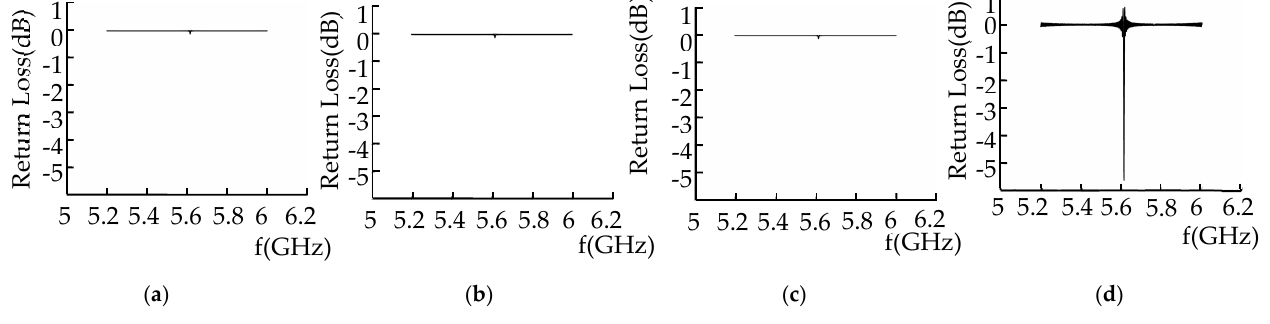
Figure 12. Return loss of different defects. ( a ) Cone defect. ( b ) Hemisphere defect. ( c ) Cylinder defect. ( d ) Half-cylinder defect.